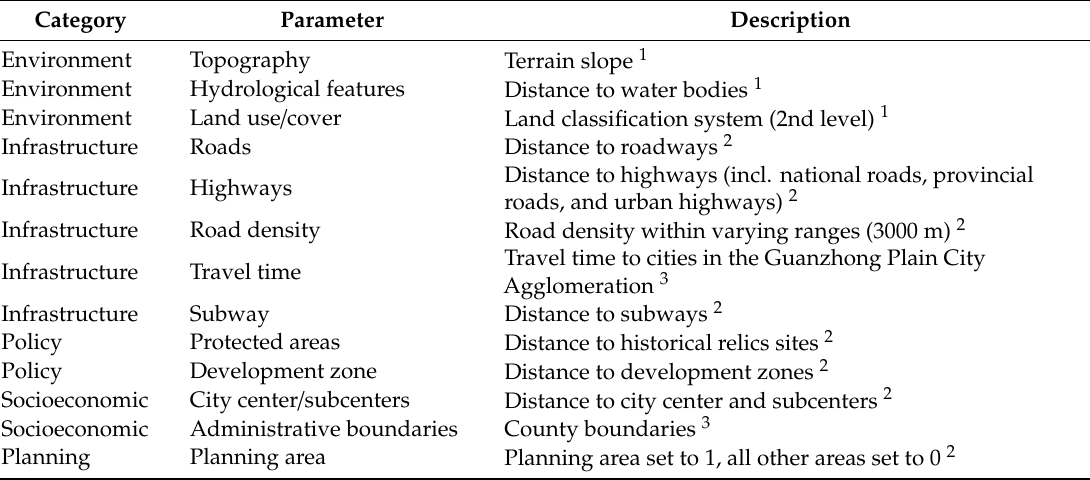
Table 1. Spatial variables considered in the logistic regression